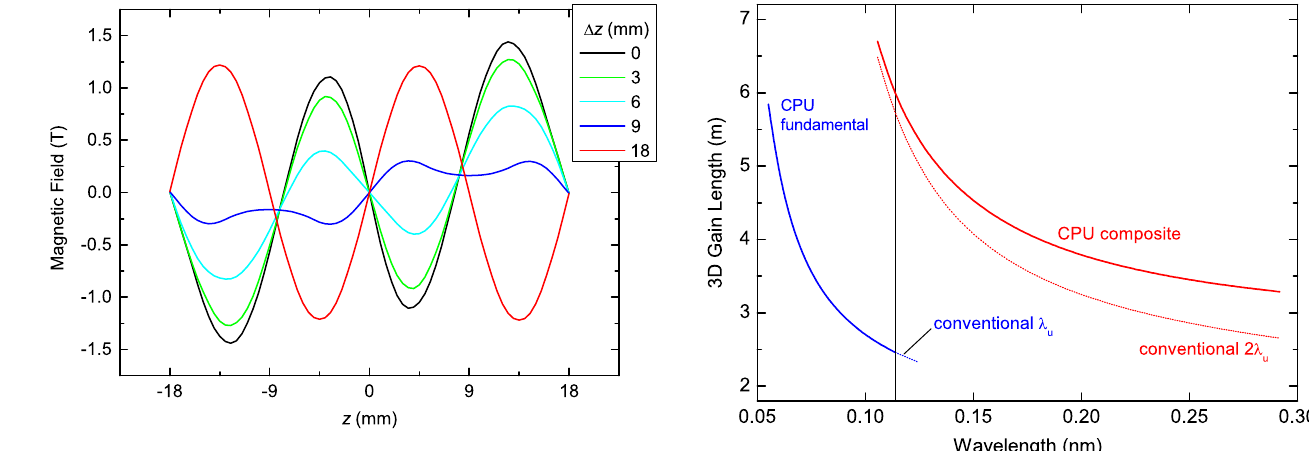
FIG. 6. Gain length as a function of the lasing wavelength in the fundamental (black line) and the composite (solid red line) modes. For reference, the gain lengths for the conventional undulators are also plotted in the solid green and dashed red lines. Refer to the text for